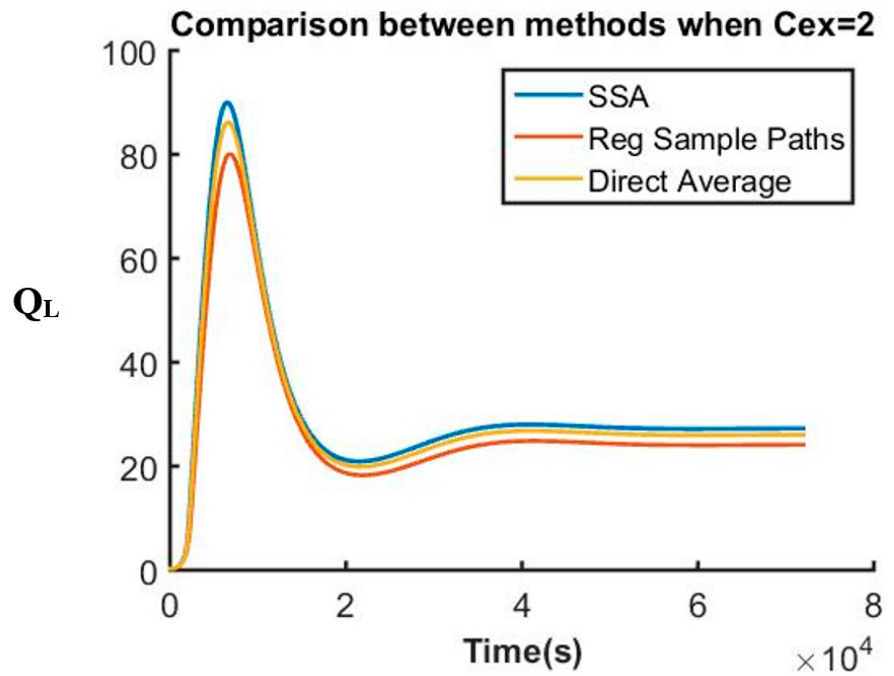
Figure 2. Q L level at a high level of inducer.